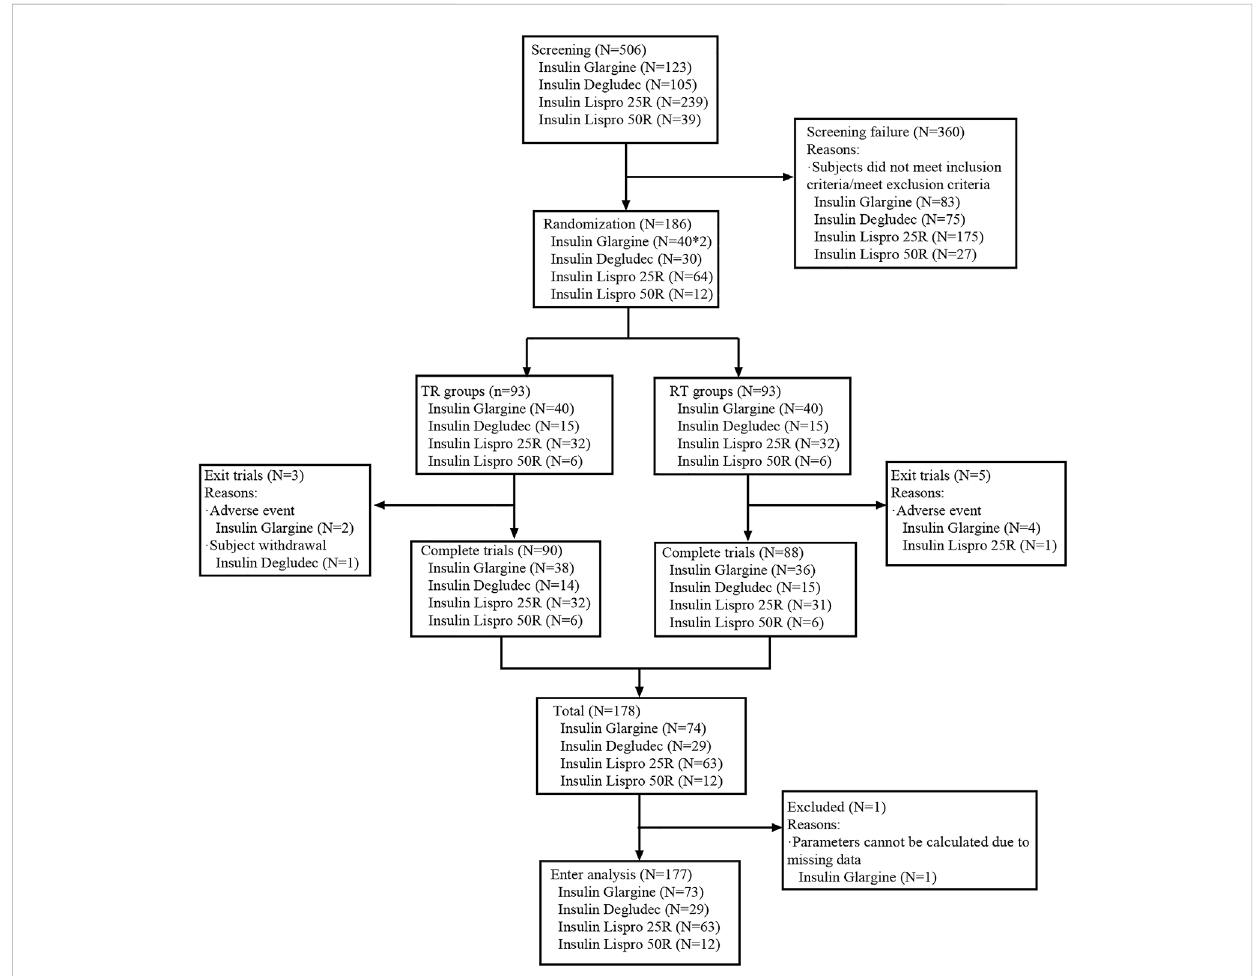
FIGURE 1 Flowchart of subjects enrolled in this study (insulin glargine carried out a four-cycle cross-design trial with two sets of